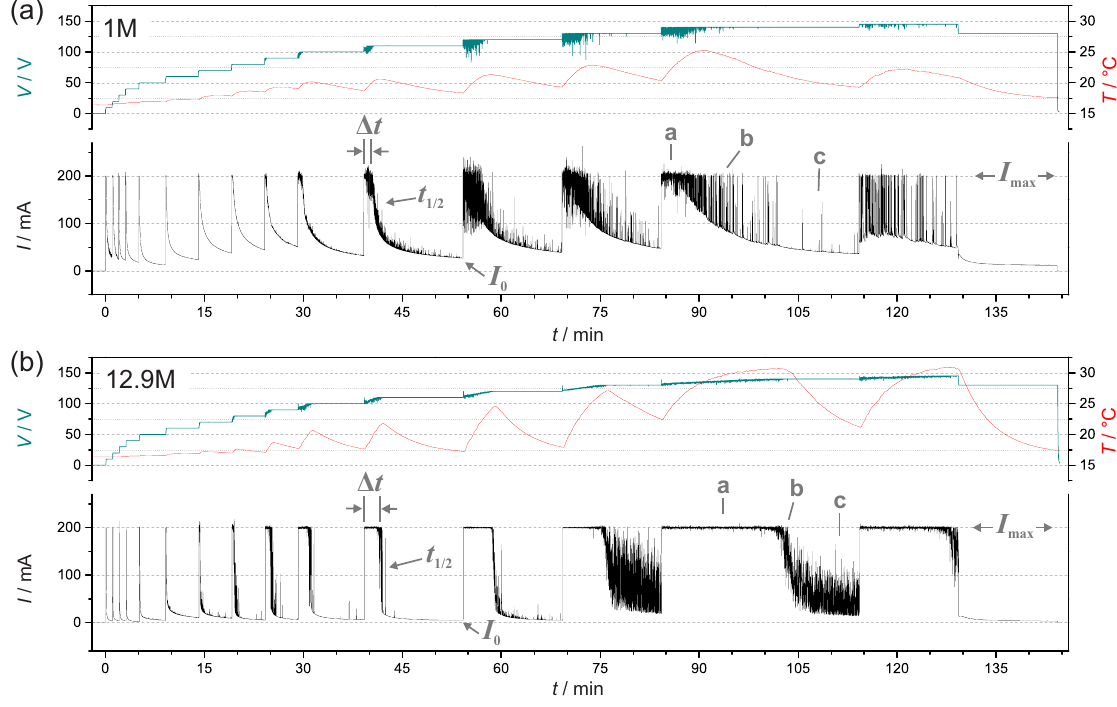
Figure 1. Voltage, current and temperature transients during the PEO process in ( a ) 1 M and ( b ) 12.9 M H 2 SO 4 electrolyte concentration. Further explanation is given in the